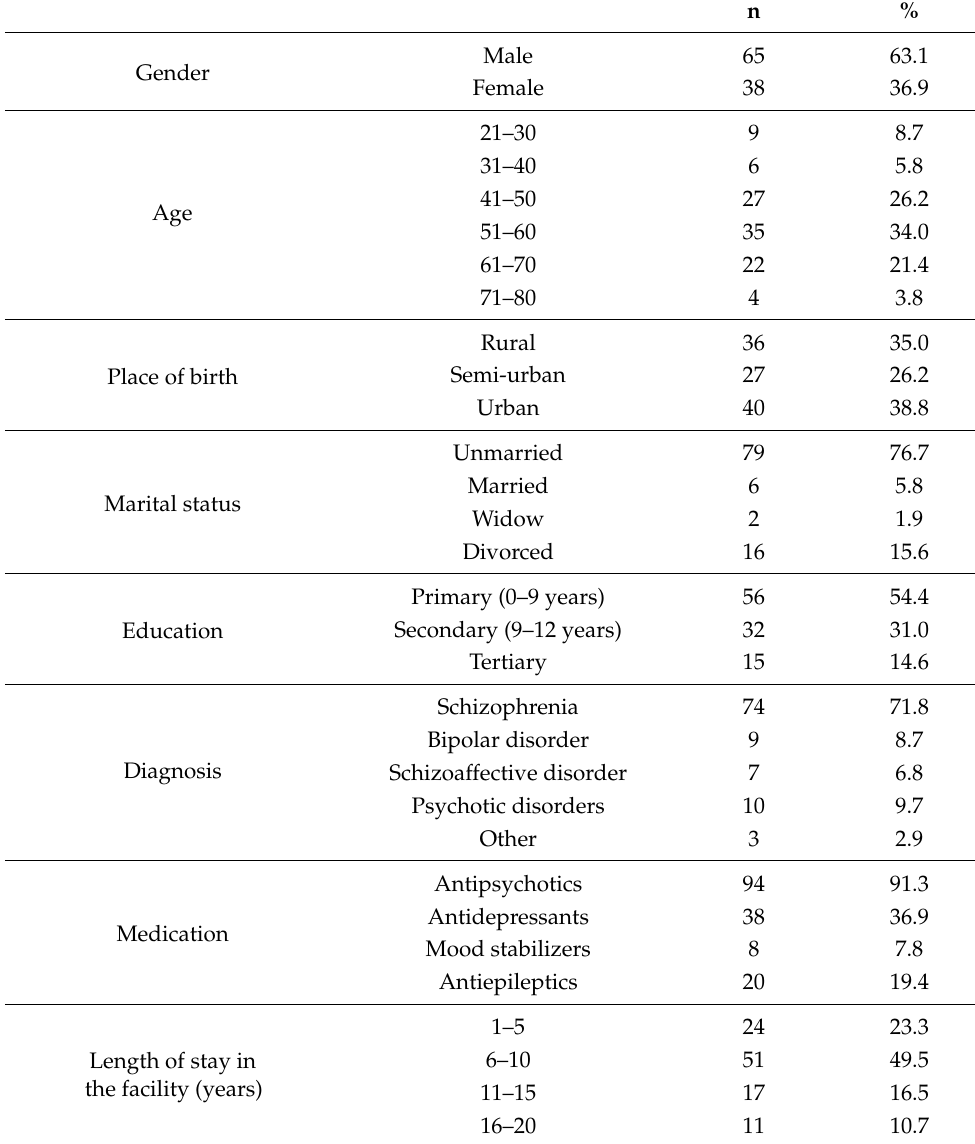
Table 1. Demographic and clinical characteristics of